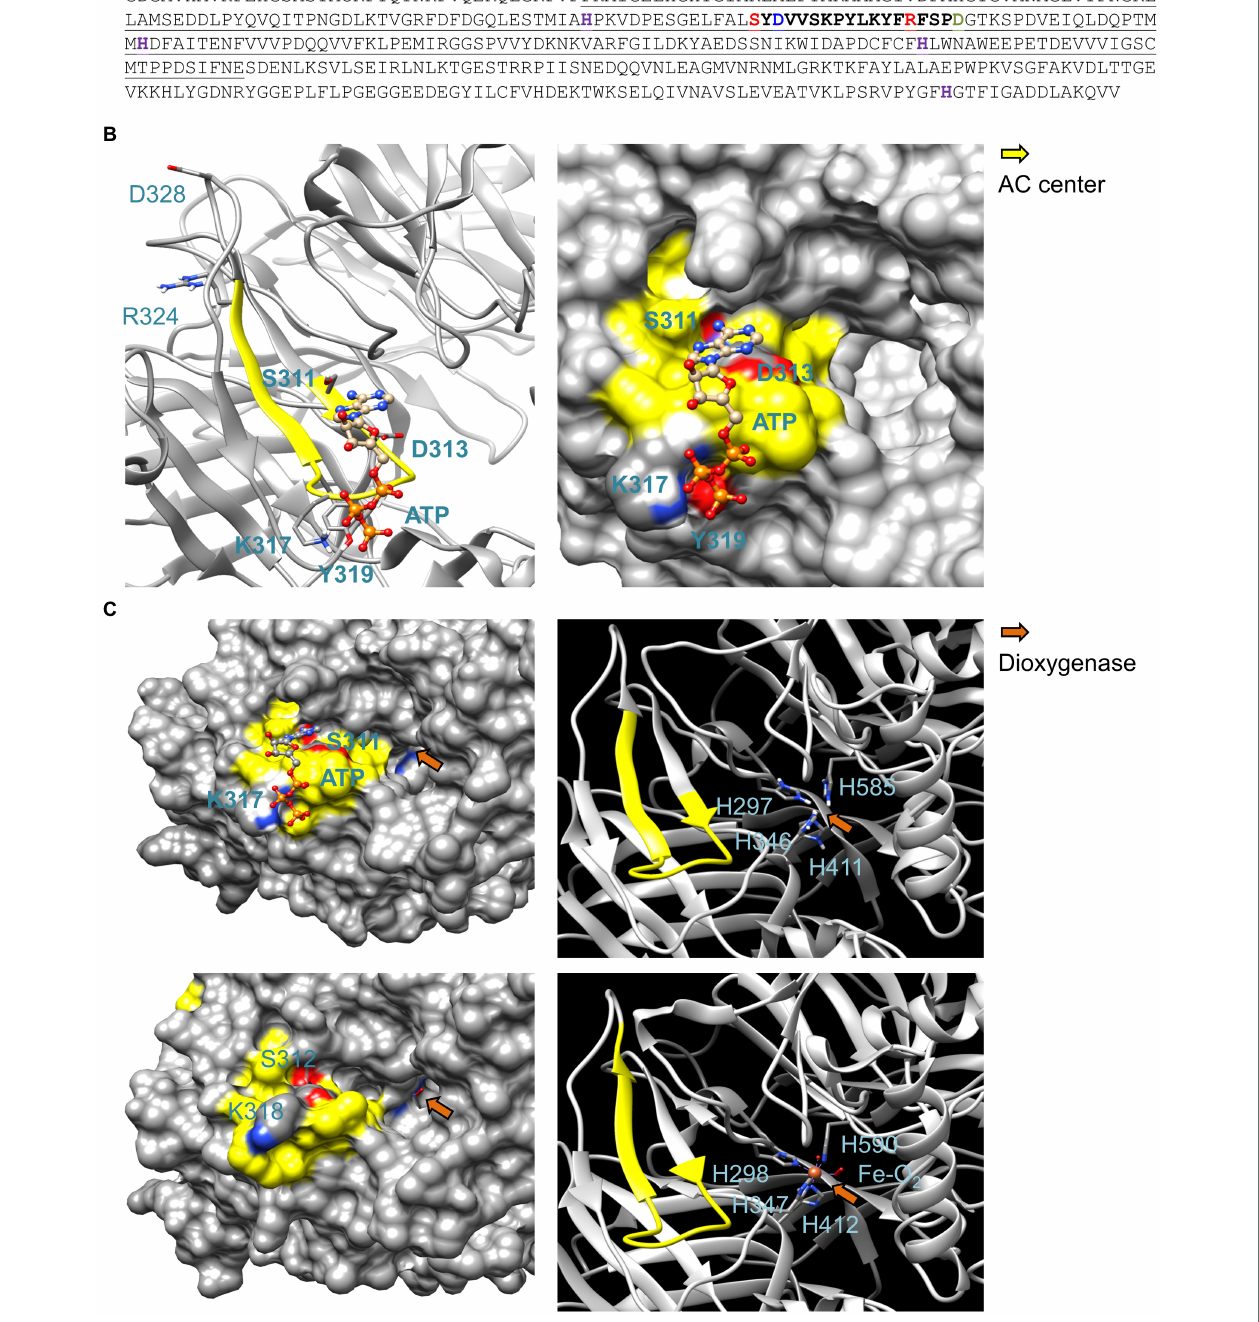
FIGURE 1 | Sequence and structural analysis of 9- cis -epoxycarotenoid dioxygenase AtNCED3. (A) AC search motif and amino acid sequence of AtNCED3. The AC center motif (S311 – R324) is bolded in the amino acid sequence where position 1 (red) forms hydrogen bond with adenine, position 3 (blue) confers substrate specificity (D or E for ATP), and position 14 stabilizes the transition (ATP/cAMP). Amino acid for Mg 2+ /Mn 2+ binding is labeled green. In the motif specific for ACs,